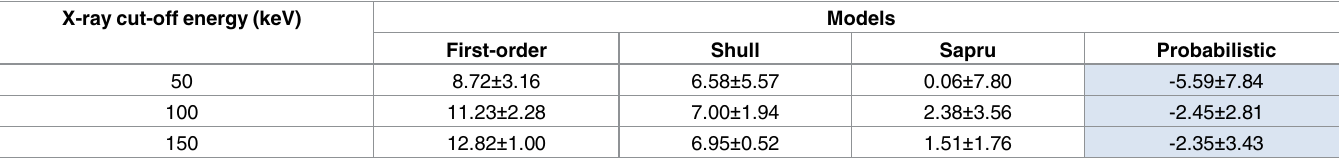
Table 2. Calculated AIC values for the four models based on